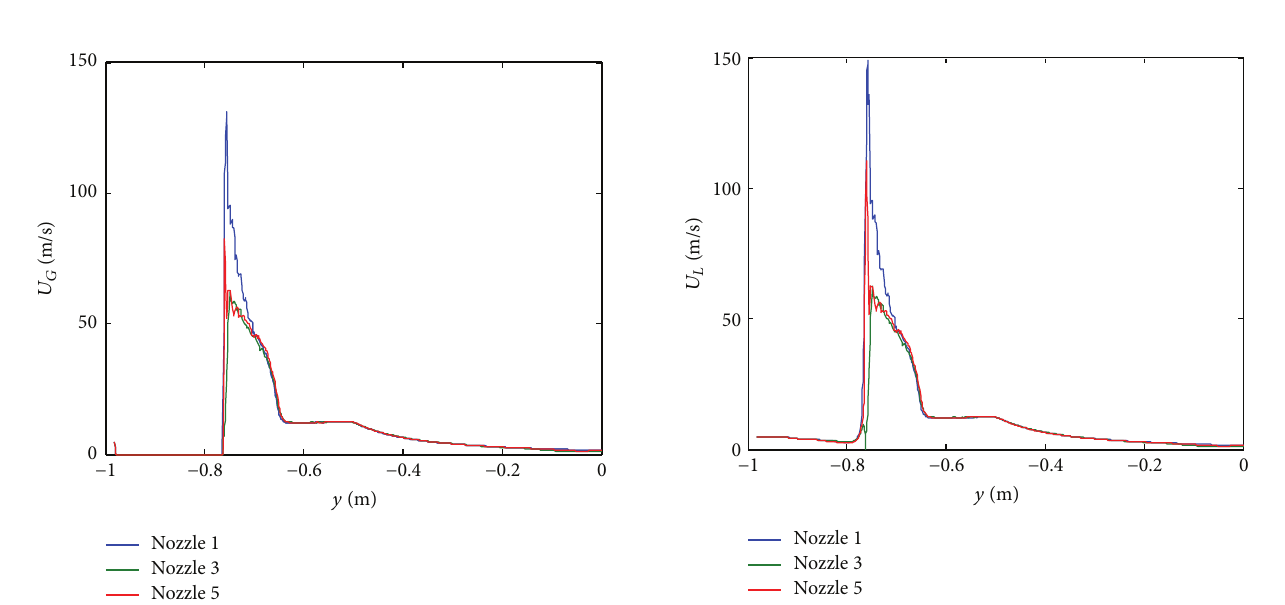
Figure 7: Plot of the velocity magnitude of gas. Figure 8: Plot of the velocity magnitude of